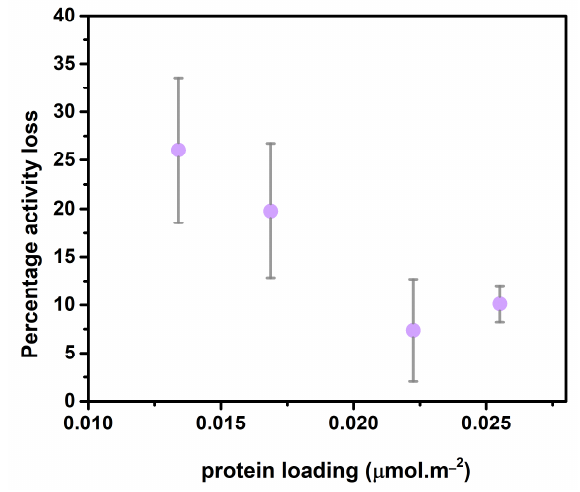
Figure 12. Activity loss in the esterification of rac -ibuprofen with ethanol at 45 °C as a function of the protein loading on Ns SiO 2 after 7 months under storage at −4 °C. It becomes clear that the higher the amount of CALB lipase is, the lower the activity loss is upon storage. In fact, the activity loss was about 25% for a protein loading below 14 mg per 100 mg of oxide support, while it fell by only 7% for loadings above 22 mg of protein per 100 mg.